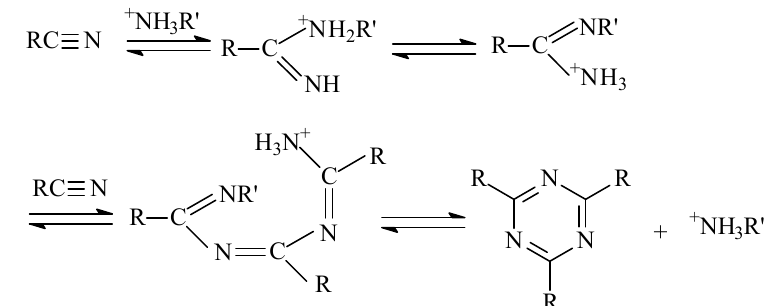
Figure 6. The mechanism of generating a triazine ring [44].